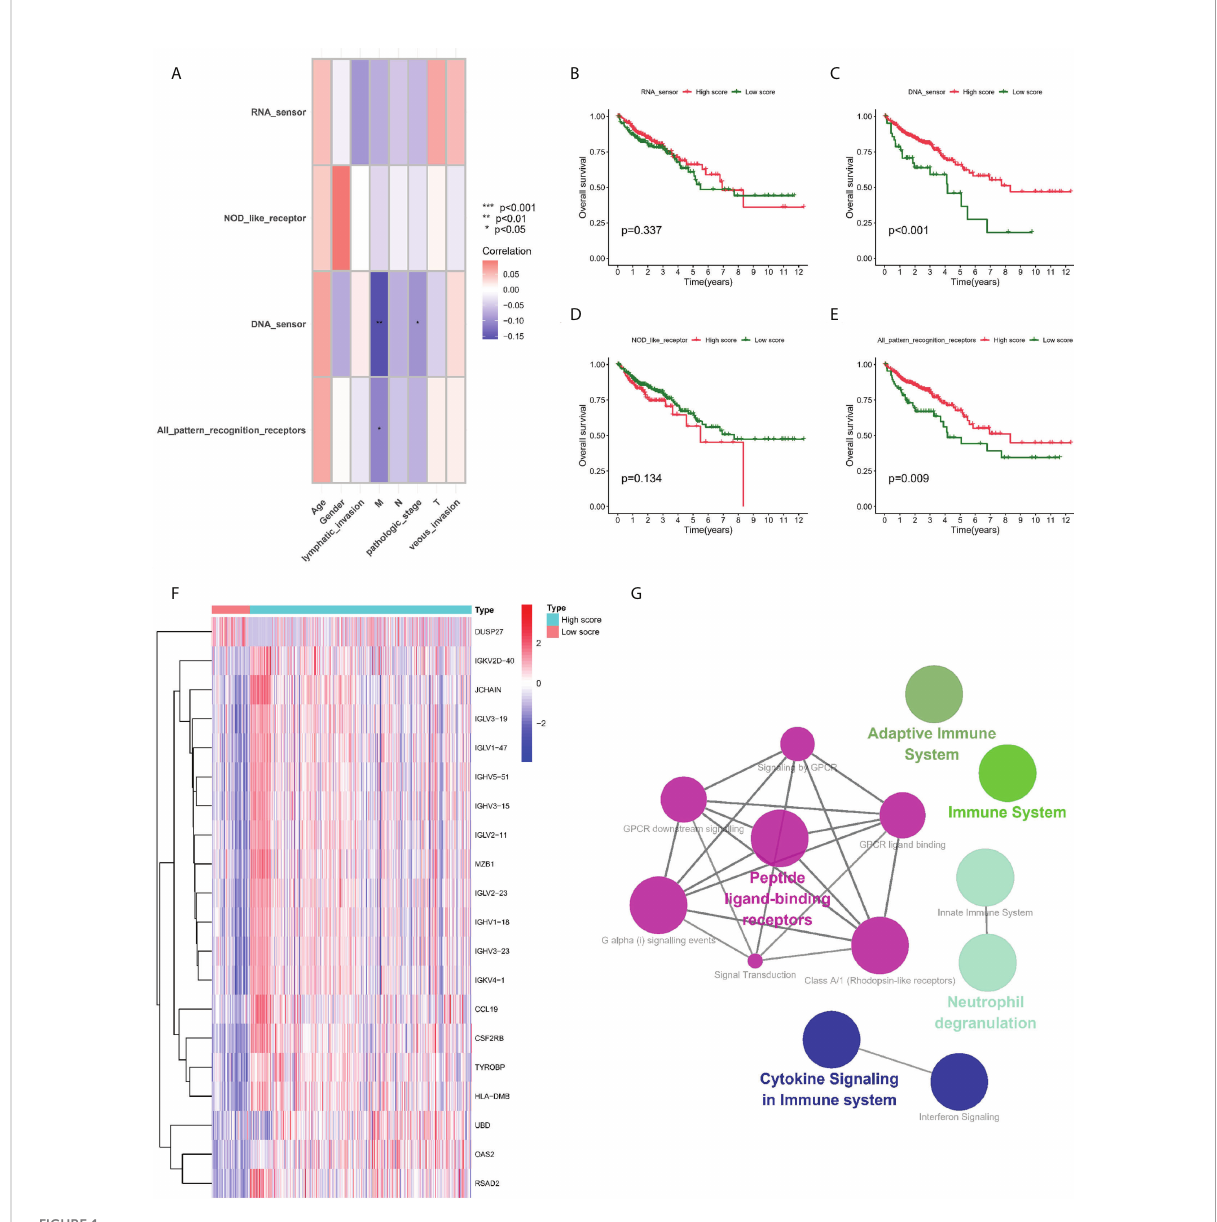
FIGURE 1 Prognostic value of PRRs. (A) Correlation between PRR enrichment scores and clinicopathological features. (B – E) Kaplan-Meier survival analysis between low-PRR enrichment scores and high-PRR enrichment scores. (F) Heatmap of DE-PRRs between low-PRR enrichment scores and high-PRR enrichment scores. (G) Enrichment analysis of DE-PRRs. *P<0.05, **P<0.01,